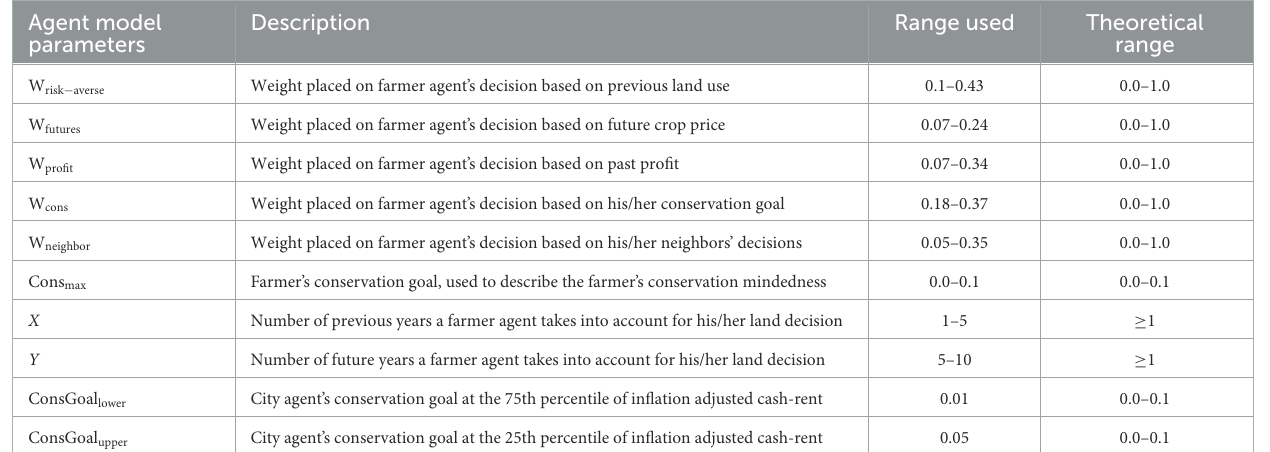
TABLE 1 Primary agent model parameters in decision-making